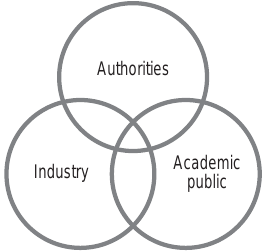
Fig. 3. The ‘triple helix’ model of overlapping elements Source: Etzkowitz et al .